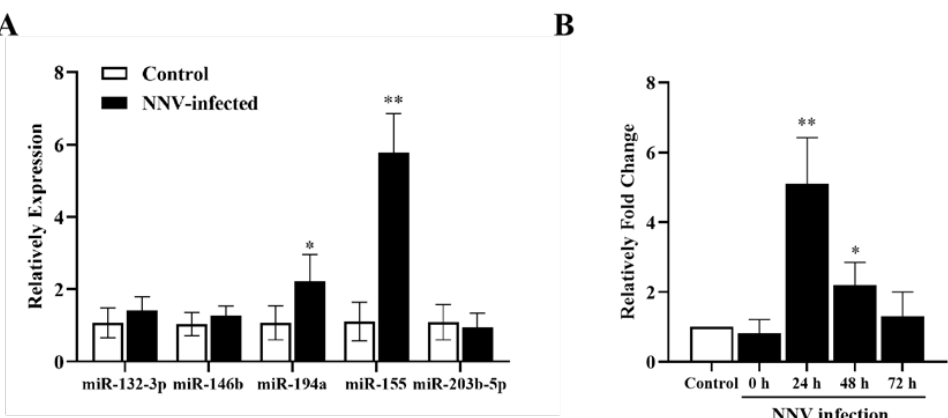
Figure 5. Infection of CAB cells with NNV increased cal-miR-155 expression. ( A ) The expression of five known DEmiRNAs were examined after CAB cells were infected with NNV (MOI = 10) after 24 h. ( B ) CAB cells were infected with NNV or PBS as a control. The cells were collected at different time points after infection to extract total RNA with TRIzol and amplified by reverse transcription. The expression of cal-miR-155 in response to NNV infection in CAB cells at 24, 48, and 72 hpi was examined by qRT-PCR. The relative fold change in cal-miR-155 expression in NNV-infected CAB cells was compared to that in PBS-infected cells control. Asterisks indicate significant differences between 0, 24, 48, or 72 hpi with the PBS-infected cells. U6 was used as an internal control. (** stands for p < 0.01; * stands for p <